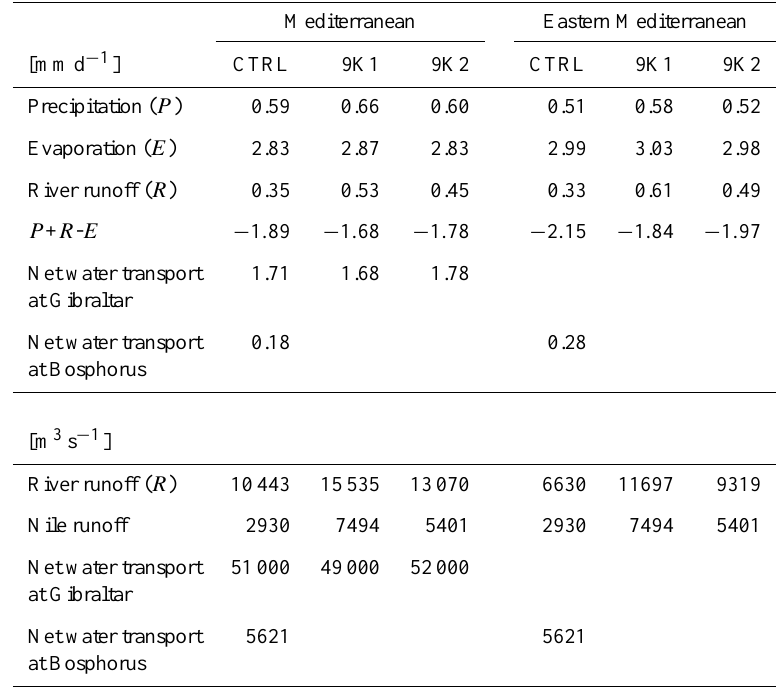
Table 1. Freshwater budget for the Mediterranean and the Eastern Mediterranean for CTRL, 9K1 and 9K2.